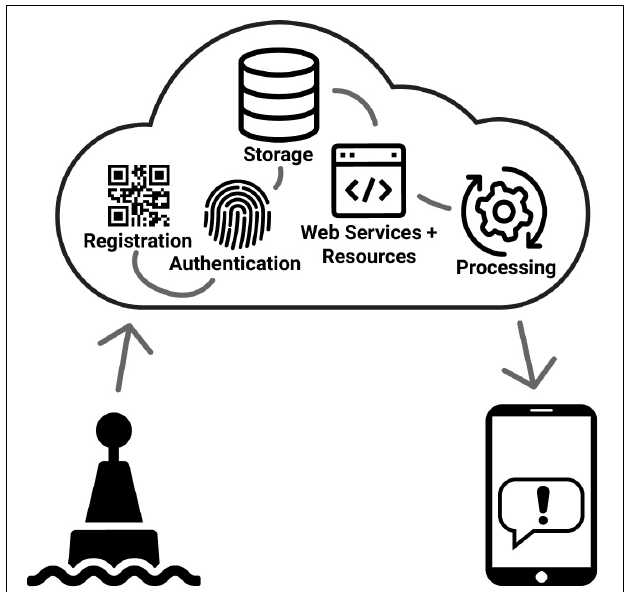
FIGURE 1 | Early Warning System